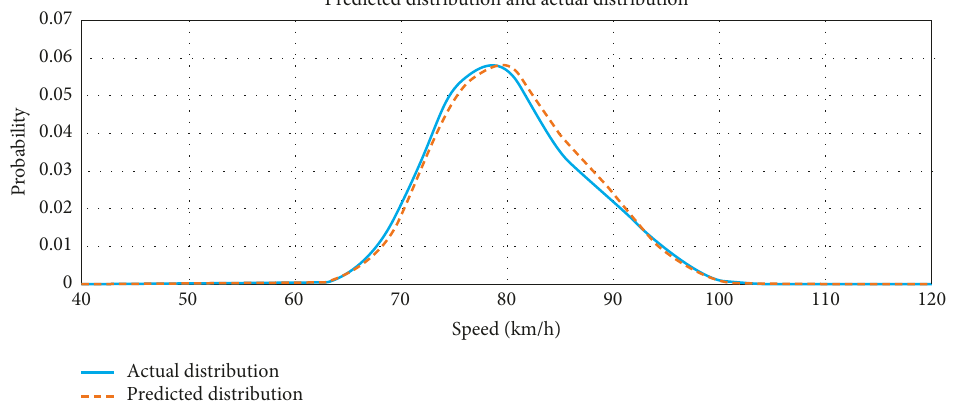
Figure 15: An example of the predicted distribution and actual distribution. Table 6: Parameters in the predicted distribution and the actual distribution.